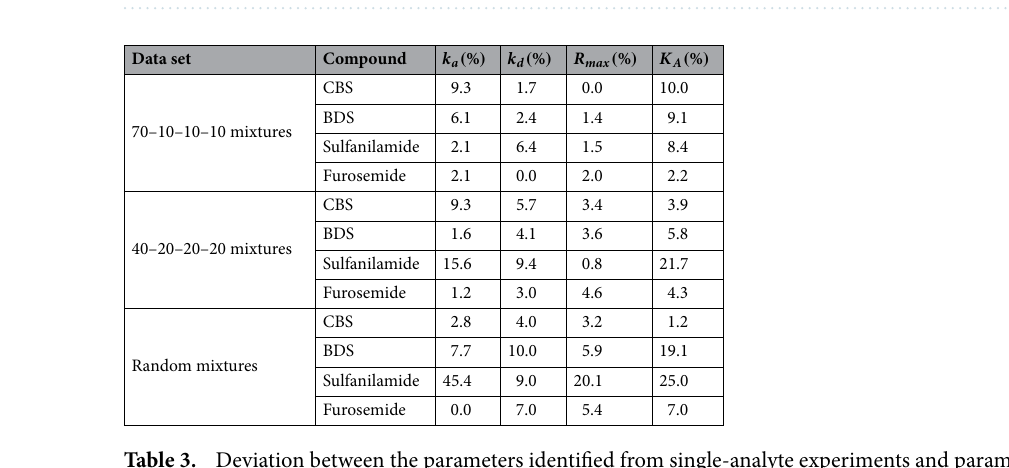
Figure 4. Kinetic analysis of the contribution of CBS (red), BDS (green), sulfanilamide (cyan) and furosemide (purple) to the SPR response of each mixture. The kinetic parameters identified from each data set (see Table 2) were used to obtain the contributions to related sensorgrams. The sum of these contributions gives the ‘global– global’ fits shown in Fig. 3, minus the bulk refractive index contribution R I . The total concentrations ( C TOT ) ranged from 300 nM to 15 μM for all mixtures. This figure was generated with the Matlab R2018b software platform (The Mathworks, Natick, USA, www.mathw orks.com/produ cts/matla b.html).